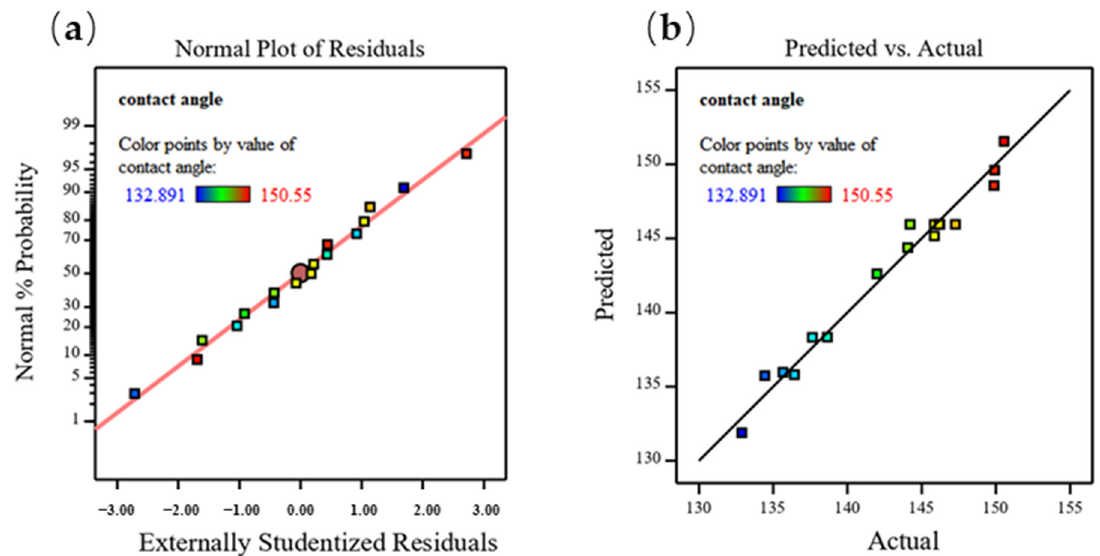
Figure 12. ( a ) Residual distribution of the contact angle. ( b ) Relationship between the predicted and actual values of the contact angle.